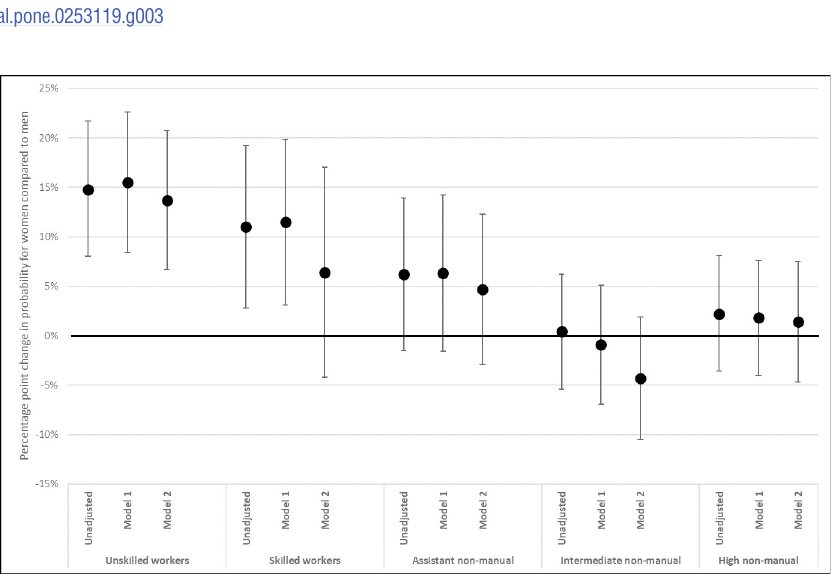
Fig 4. Gender differences in probability of less than good SRH, by class. Coefficients (for woman = 1) interpreted as percentage point change in probability for less than good SRH. From class-separate linear probability models, with 95% confidence intervals (Table F in S4 Appendix). Unadjusted model regresses SRH on gender, separately by class. Stepwise adjustment for physical working conditions (Model 1) and psychosocial working conditions (Model 2). Both unadjusted and adjusted models are controlled for age and